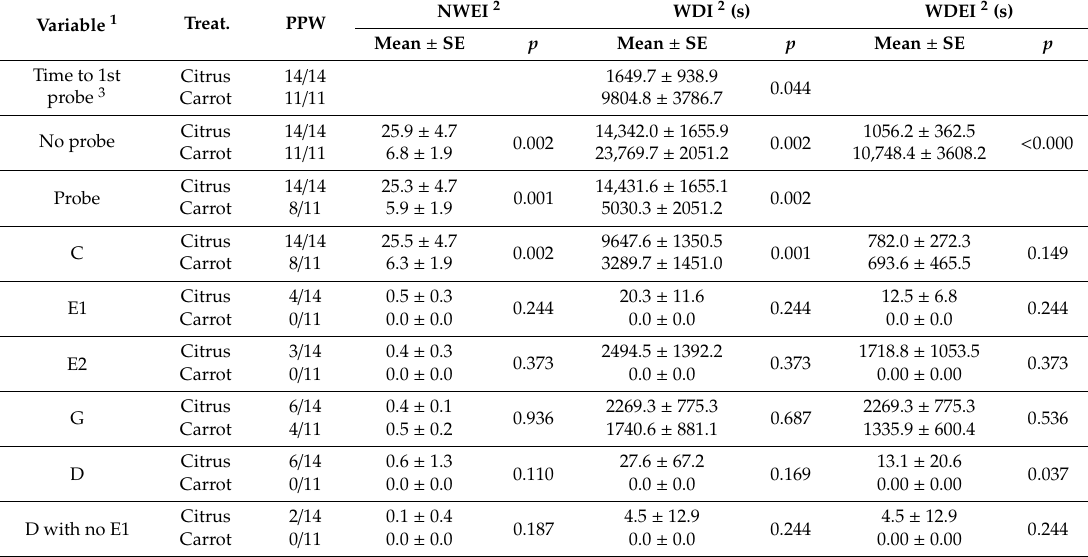
Table 2. Variables of feeding behavior, monitored by electrical penetration graphs (EPGs), of T. erytreae species in citrus plants and carrot plants (means ± standard errors (SEs)) of the sequential and nonsequential